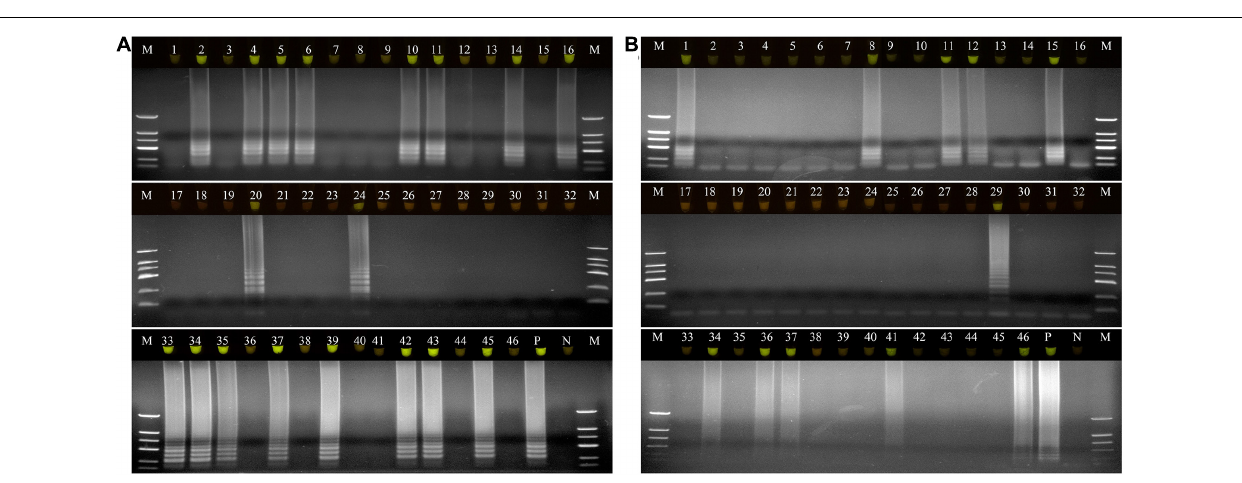
FIGURE 6 | The detection results of Serratia marcescens by loop-mediated isothermal amplification (LAMP) in Fuzi and rhizosphere soil samples. (A) The detection results of Serratia marcescens by LAMP in Fuzi samples. Lanes 1–46: different Fuzi samples. (B) The detection results of Serratia marcescens by LAMP in Fuzi rhizosphere soil samples. Lanes 1–46: different Fuzi rhizosphere soil samples. (Up) LAMP products visualized with gelgreen. Under daylight, positive reactions are shown by bright green color, and negative reactions are dark red color. (Down) LAMP products determined by agarose gel electrophoresis. Lane M: DNA marker DL2000. Lane P: positive control ( Serratia marcescens X2). Lane N: negative control (ddH 2